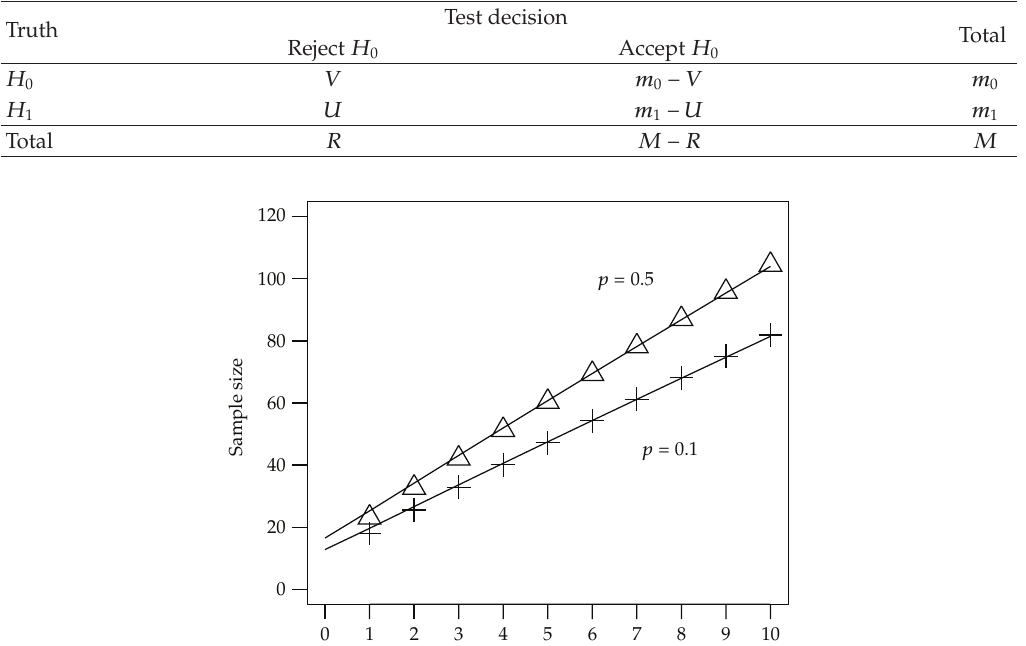
Table 2: Possible outcome for testing M hypotheses.